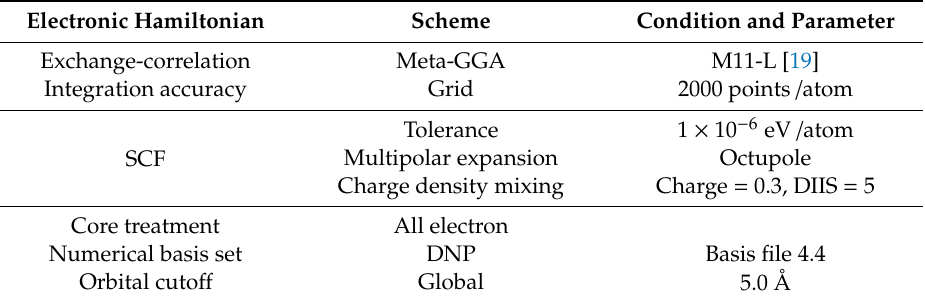
Table 2. Schemes and parameters adopted in the first-principles calculations by